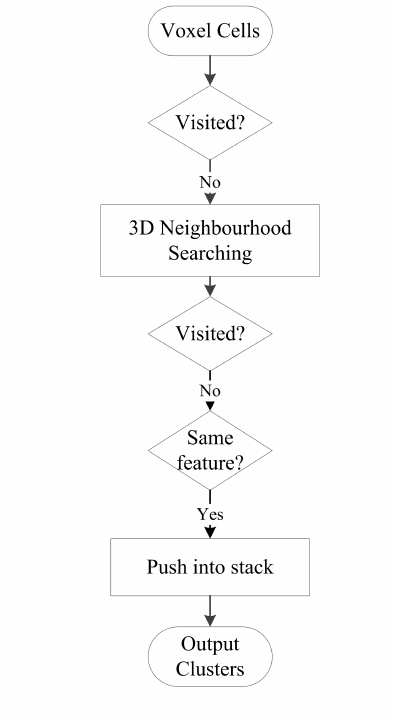
Figure 3: Modified 3D seed filling clustering of voxel cells cells is visited, visited, if not, then its 26 neighbor cells are searched.